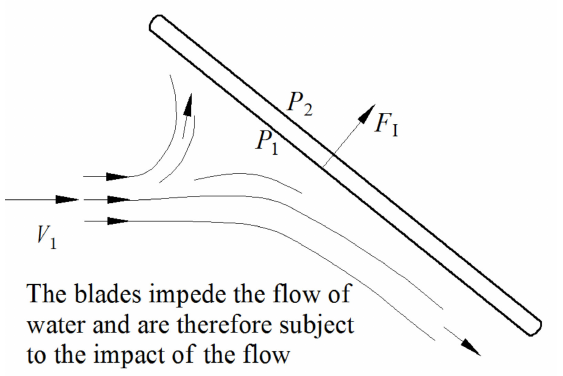
Figure 4. Static analysis of the impact resistance.